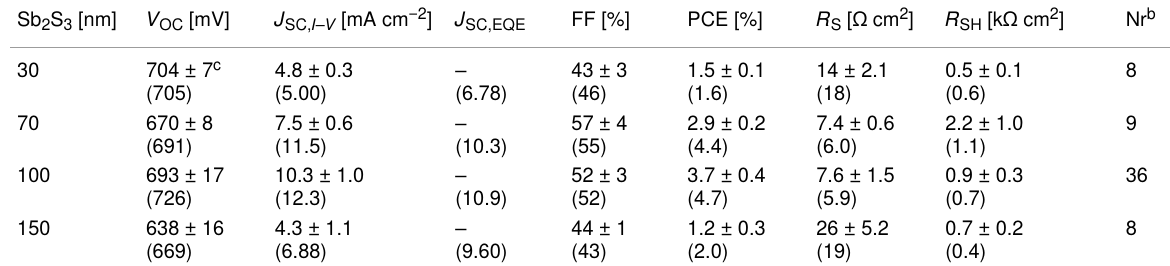
Table 1: Photoconversion parameters a of solar cells as a function of Sb 2 S 3 film thickness. The best results are given in parentheses. Sb 2 S 3 [nm] V OC